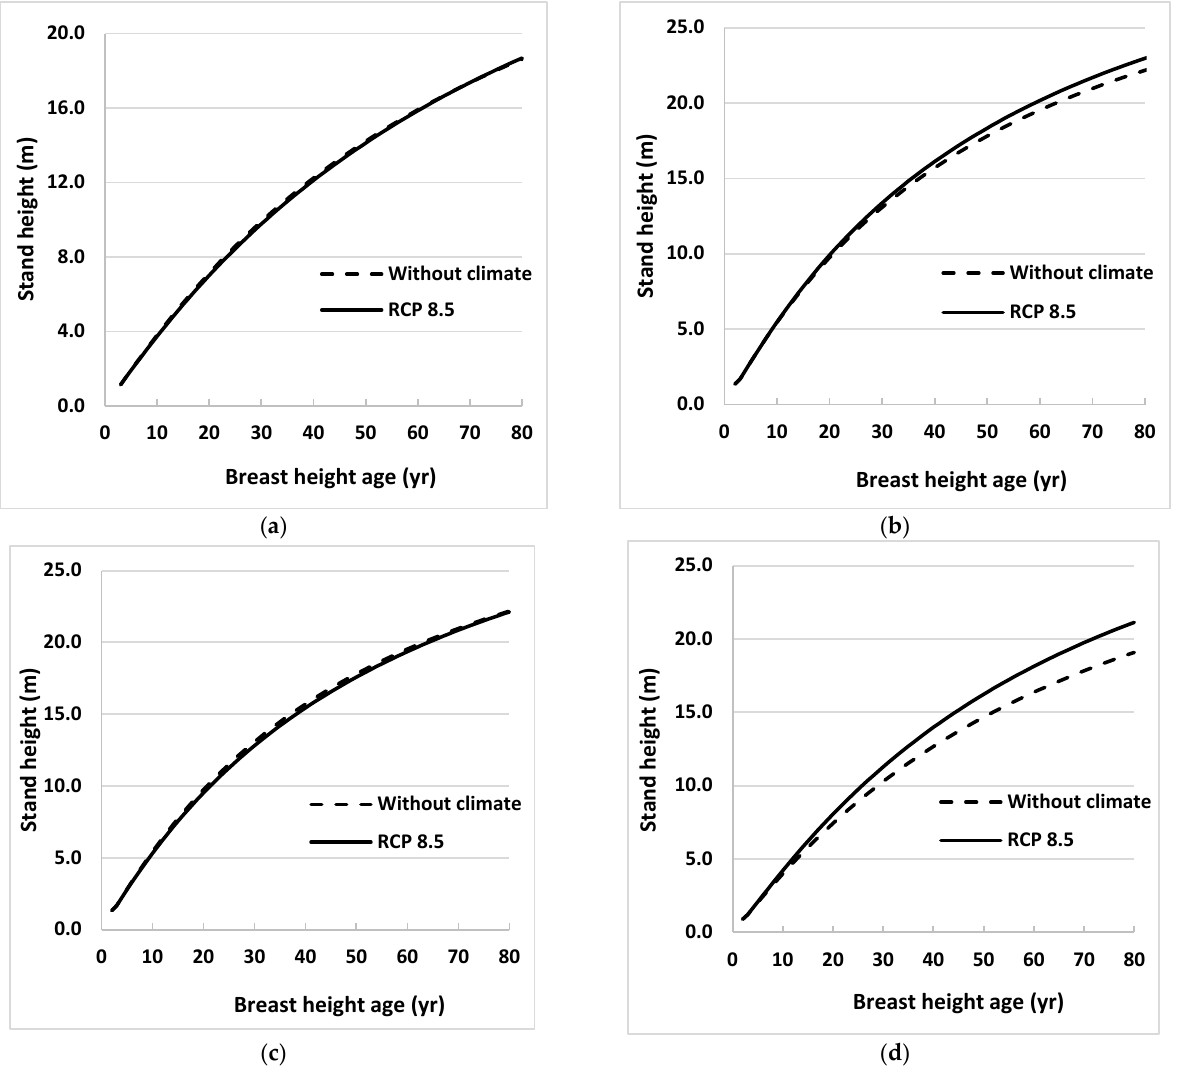
Figure 3. Stand height profiles for natural origin trembling aspen trees generated using projected values of climate variables for the period 2021 to 2080, assuming that climate remains stable (with- out climate) or warms (RCP 8.5), in Equation (3) for ( a ) eastern (near Timmins), ( b ) central (near Hearst), ( c ) western (near Thunder Bay), and ( d ) far western (near Kenora), ON, Canada. Climate variables were projected for locations close to sample sites using 3 emissions trajectories known as representative concentration pathways (RCPs).